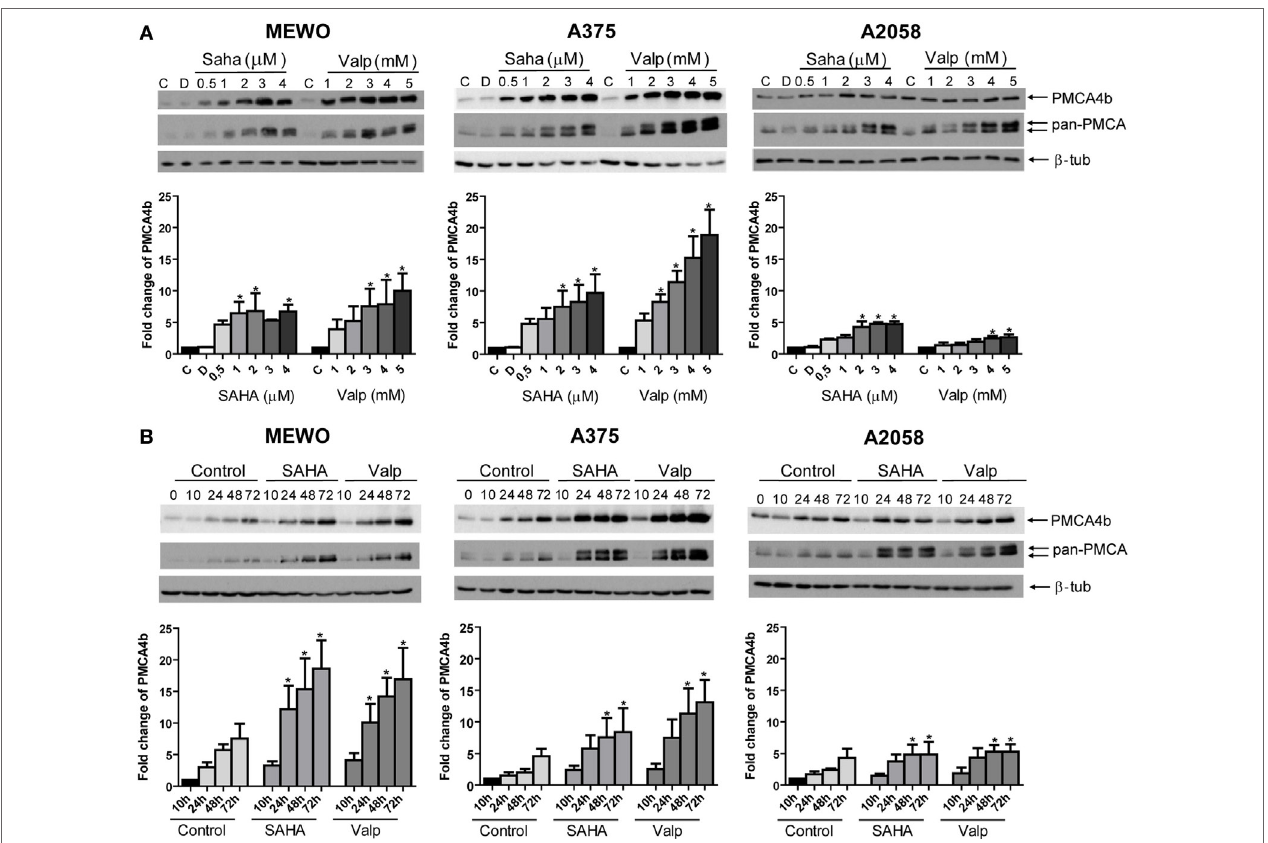
FigUre 1 | PMca4b is upregulated in both BraF wild-type and BraF-mutant melanoma cells after histone deacetylase inhibitor (hDaci) treatment . (a) One BRAF wild-type (MEWO) and two BRAF-mutant (A375, A2058) cell lines were treated with HDACi SAHA or valproate in increasing concentrations for 48 h. DMSO (D) treatment was included as vehicle control. The protein level of PMCA4b and PMCA1 proteins were analyzed by Western blotting of total cell lysates (30 µg per sample) with PMCA4b-specific and pan-PMCA antibodies. Western blots were analyzed by densitometry. (B) Change in PMCA protein expression level was investigated after treatment with SAHA (2 µM) or valproate (2 mM) for 10, 24, 48, and 72 h with PMCA4b-specific and pan-PMCA antibodies. Western blots were analyzed by densitometry. Data were normalized to the expression levels of β -tubulin, and changes in PMCA4b protein level were expressed as fold increase over the untreated controls. Bars represent mean ± SE from three independent experiments. Asterisks indicate significant differences (* p < 0.05) from control, as calculated by ANOVA and Dunnett’s post hoc